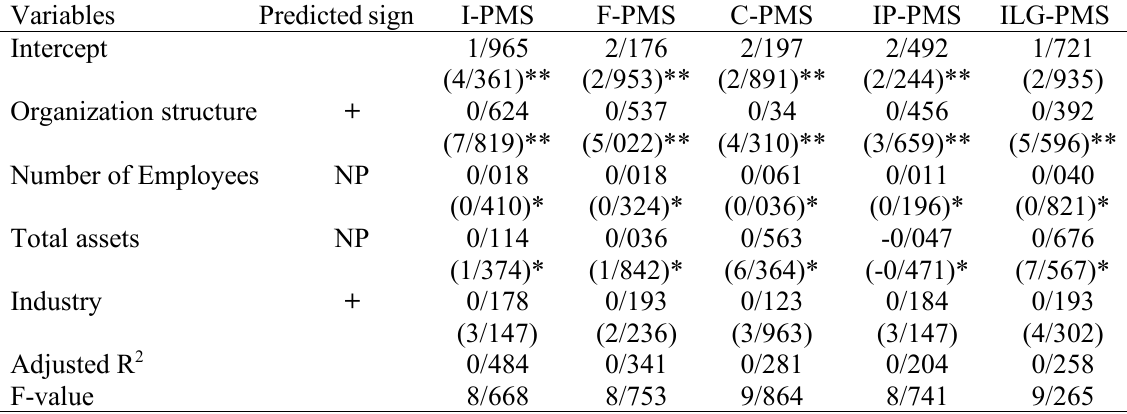
Table 7 . The relationship between organization structure and the use of integrated PMS